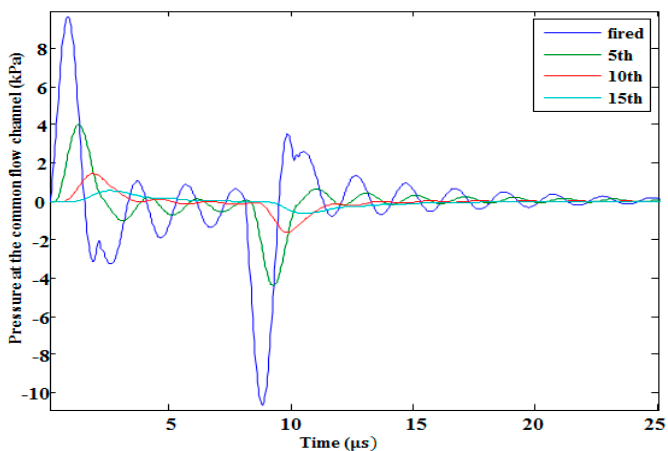
Figure 19. Cross-talk effect of the central activated nozzle on the neighboring non-activated nozzles.